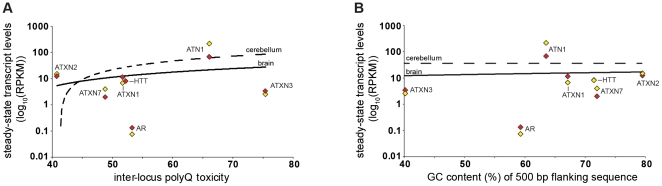
Steady-state transcript levels in human brain do not correlate with inter-locus toxicity or flanking DNA GC content.(A) Correlation (Pearson, r) between inter-locus toxicity and polyQ gene steady-state transcript levels in whole brain (r = 0.33, P = 0.47; yellow diamond) or cerebellum (r = 0.37, P = 0.31; red diamond). (B) Correlation (Pearson, r) between 500 bp flanking DNA GC (%) content and polyQ gene steady-state transcript levels in whole brain (r = 0.07, P = 0.89) or cerebellum (r = 0.34, P = 0.46). Similarly, no significant correlation was observed between polyQ gene steady-state transcript levels and 100 bp flanking DNA GC (%) content (brain, r = −0.07, P = 0.89; cerebellum, r = −0.09, P = 0.85) or 2000 bp flanking DNA GC (%) content (brain, r = 0.37, P = 0.41; cerebellum, r = 0.34, P = 0.46). Steady-state transcript levels values are averages of values from multiple independent samples of normal human whole brain (N = 2, yellow diamond) and cerebellum (N = 6, red diamond). The least squares linear regression lines are shown for whole brain (solid) and cerebellum (dashed). Steady-state transcript levels were calculated as ‘reads per kilobase of exon model per million mapped reads’ (RPKM) [59]. RPKM values are shown in log10 scale for.